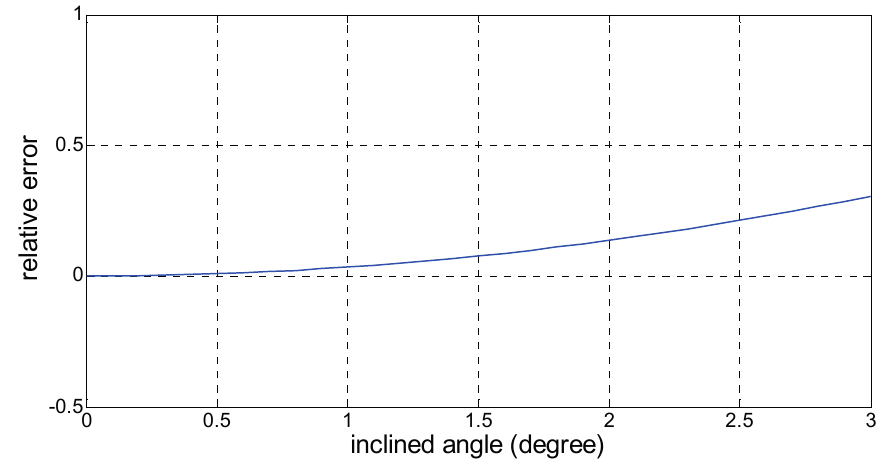
Figure 16. The relationship of the inclined angle with the relative